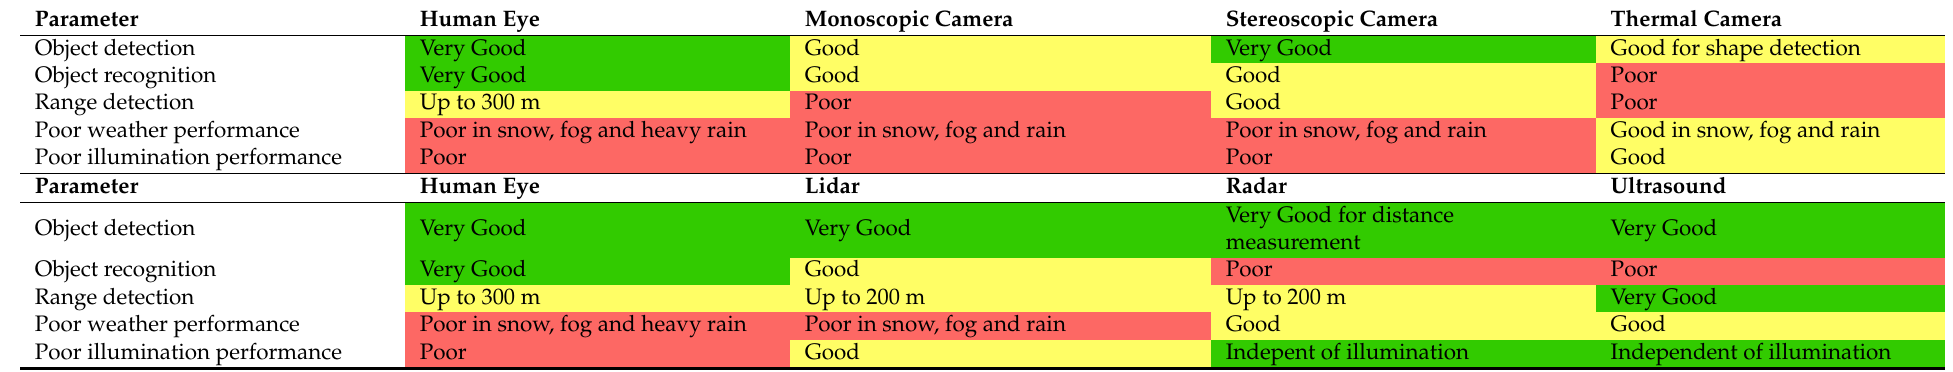
Table A1. Comparison of the human eye performances to other vehicular sensors. Green means the sensor works ideally for the given situation, yellow that it is of acceptable range, and red that it works poorly for a specific role.